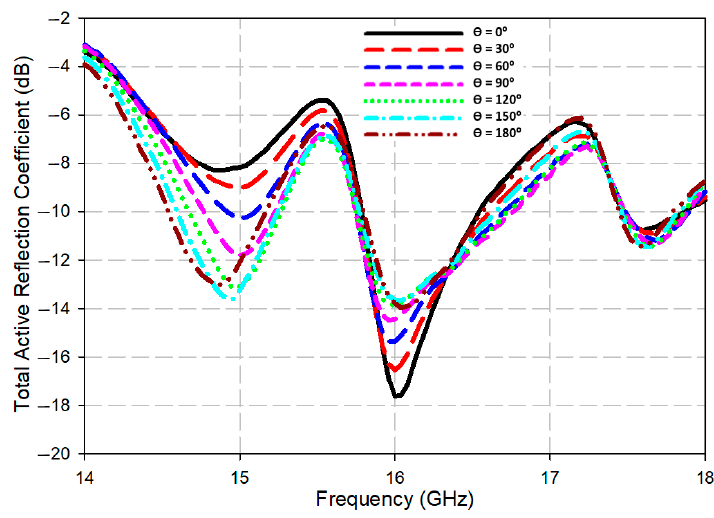
Figure 13. Measurement of total average reflection coefficient (TARC).